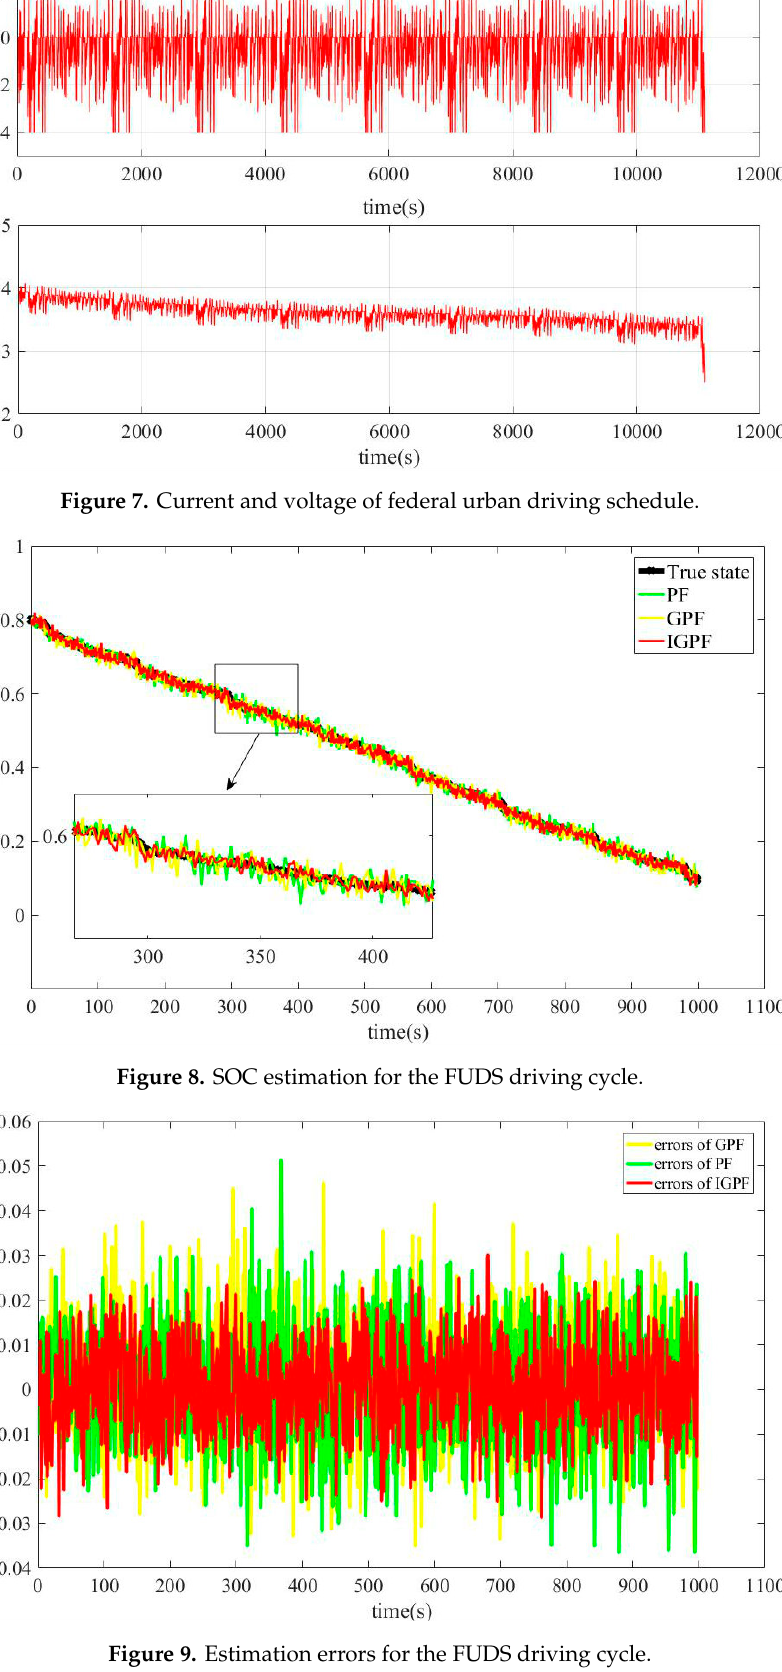
Figure 9. Estimation errors for the FUDS driving cycle.